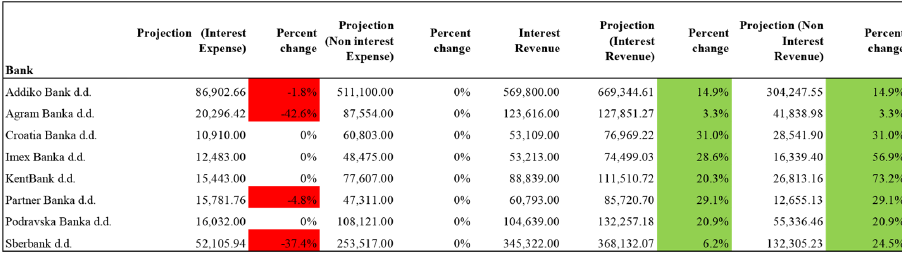
Figure 6. Targets for improvement for the inefficient Croatian commercial banks (in 000 HRK).